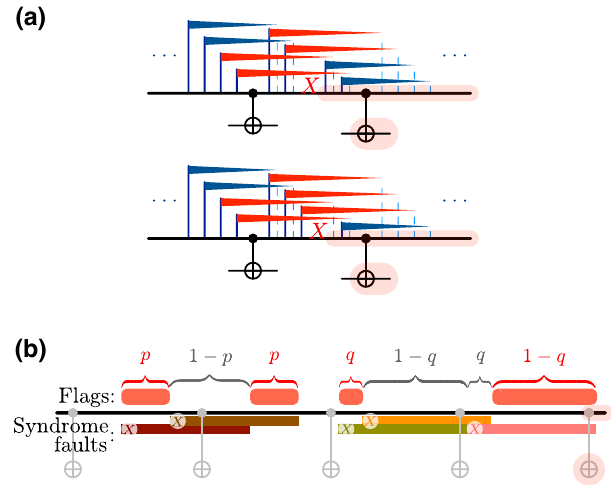
FIG. 4. (a) A syndrome fault can flip 2 t or 2 t + 1 flags. (b) Syndrome faults spread to the data and flip intervals of